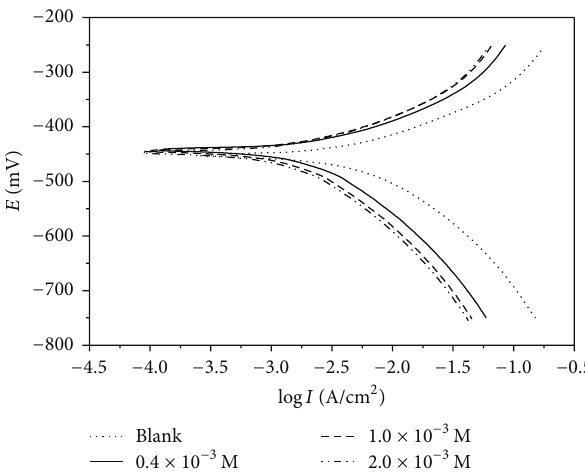
Figure 5: Polarization curves for mild steel in 1N H 2 SO 4 in the absence and presence of different concentration of inhibitor (01).